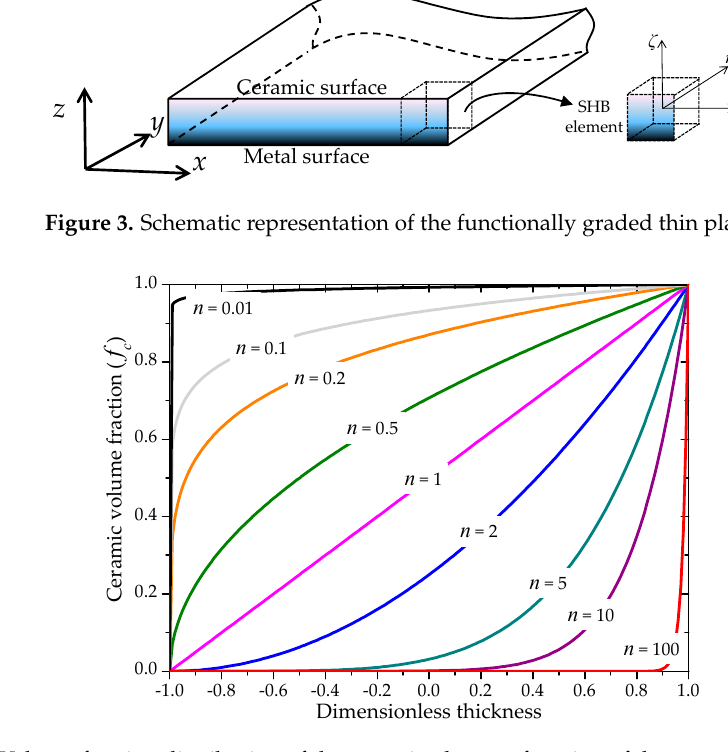
Figure 4. Volume fraction distribution of the ceramic phase as function of the power-law exponent n .